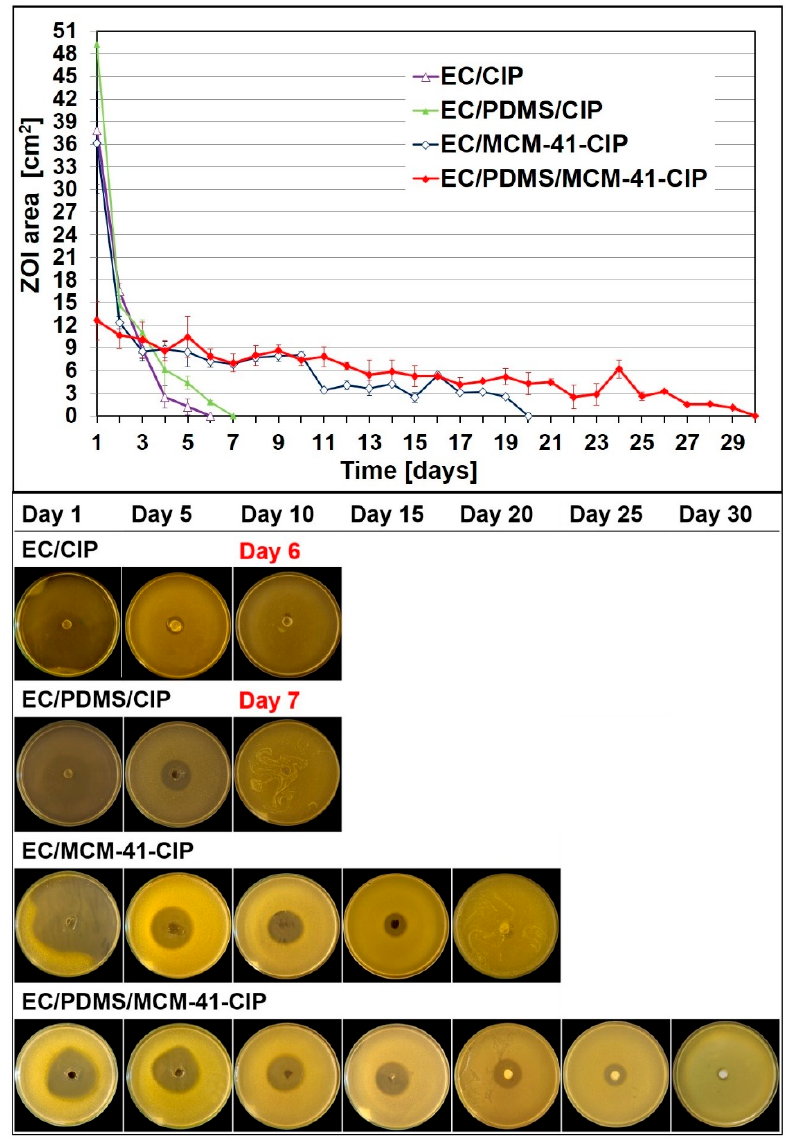
Figure 5. Modified agar diffusion test for composites (EC/CIP, EC/PDMS/CIP, EC/MCM-41-CIP, EC/PDMS/MCM-41-CIP) with the mean values of areas of ZOI [cm 2 ] with standard deviations and representative images of ZOI for particular